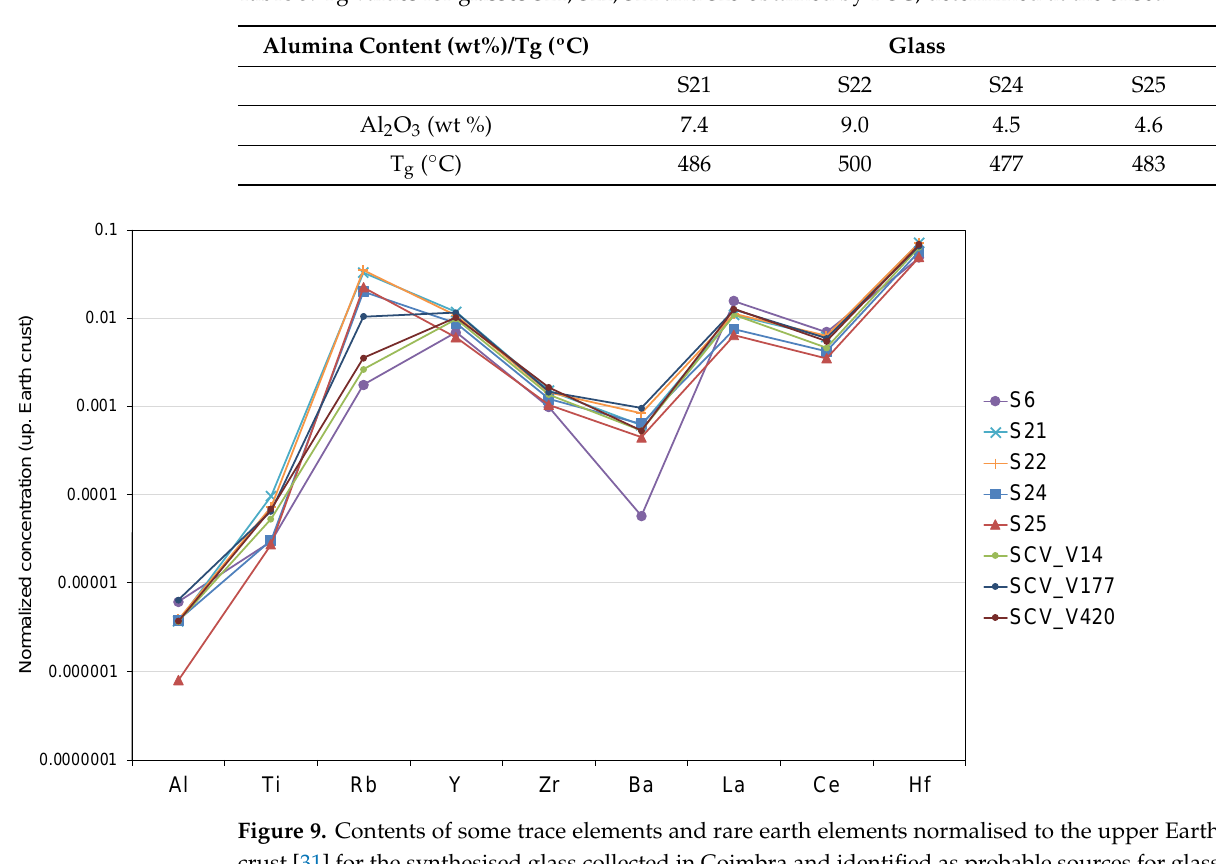
Table 5. Tg values for glasses S21, S22, S24 and S25 obtained by DSC, determined at the onset.